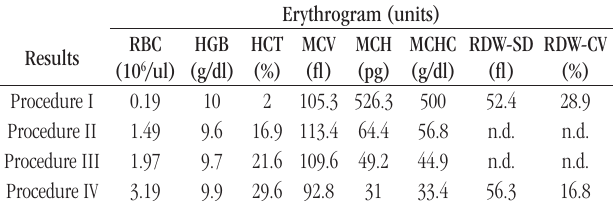
taBLE − Results of the erythrogram for procedures I, II, III and IV Erythrogram